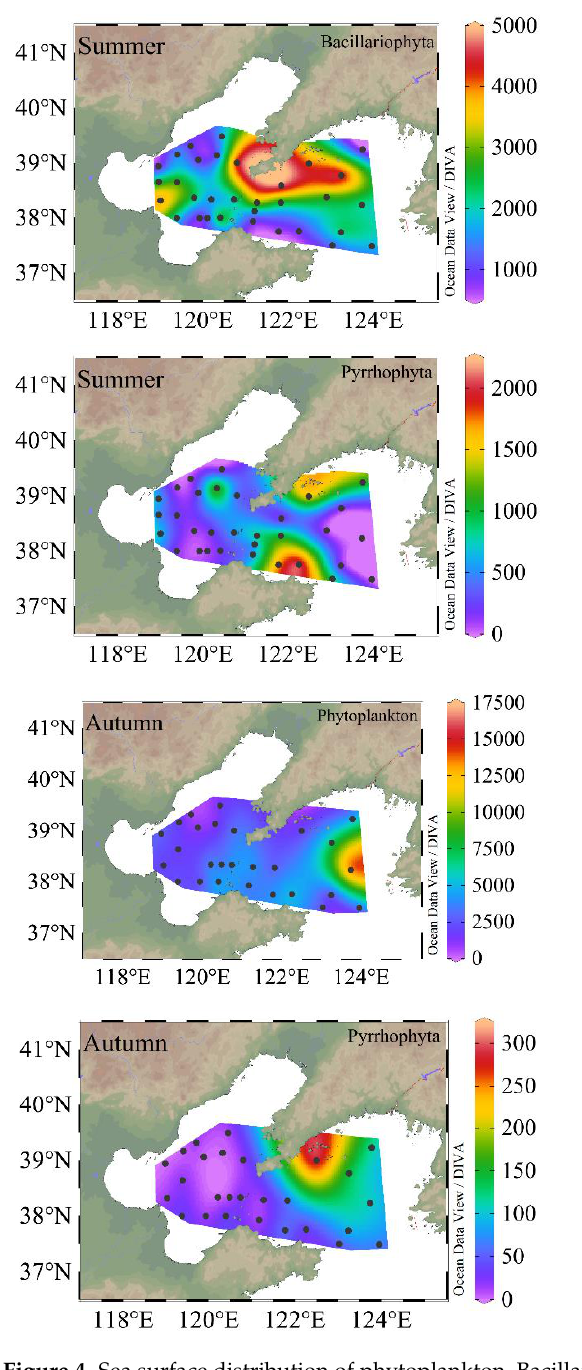
Figure 4. Sea surface distribution of phytoplankton, Bacillariophyta, Pyrrhophyta, and Chrysophyta (cells · L − 1 ) in different seasons. The color bar is cell abundance.